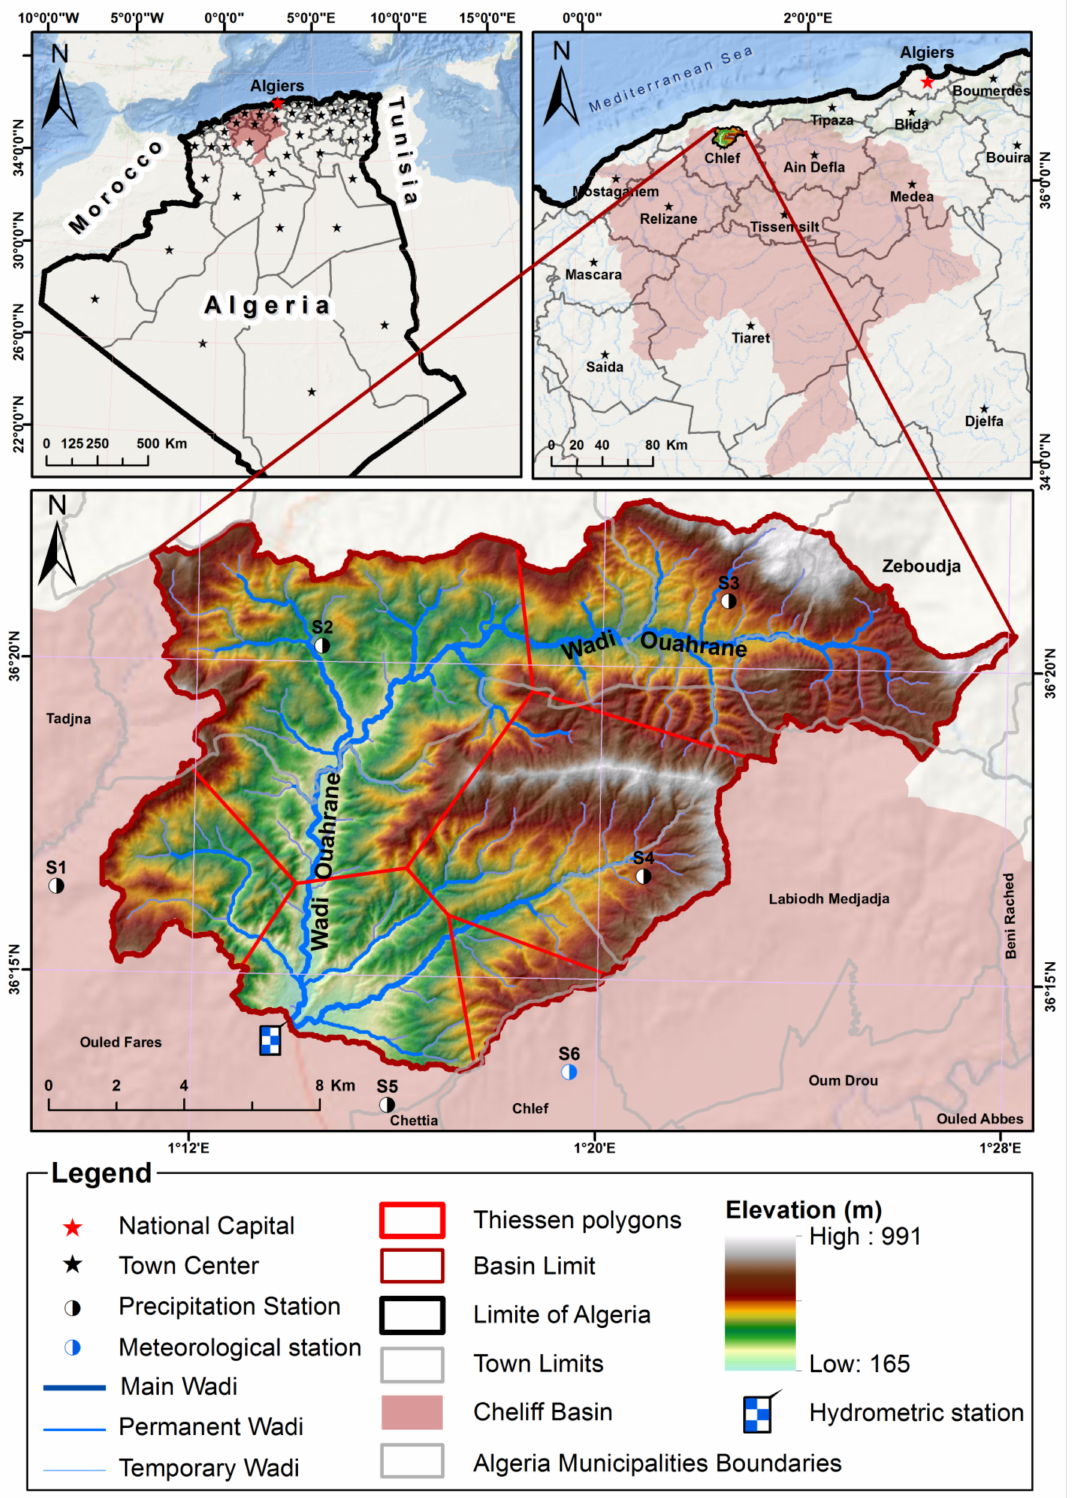
Figure 1. Location, topographic characteristics, pluviometric, and hydrometric network of the study